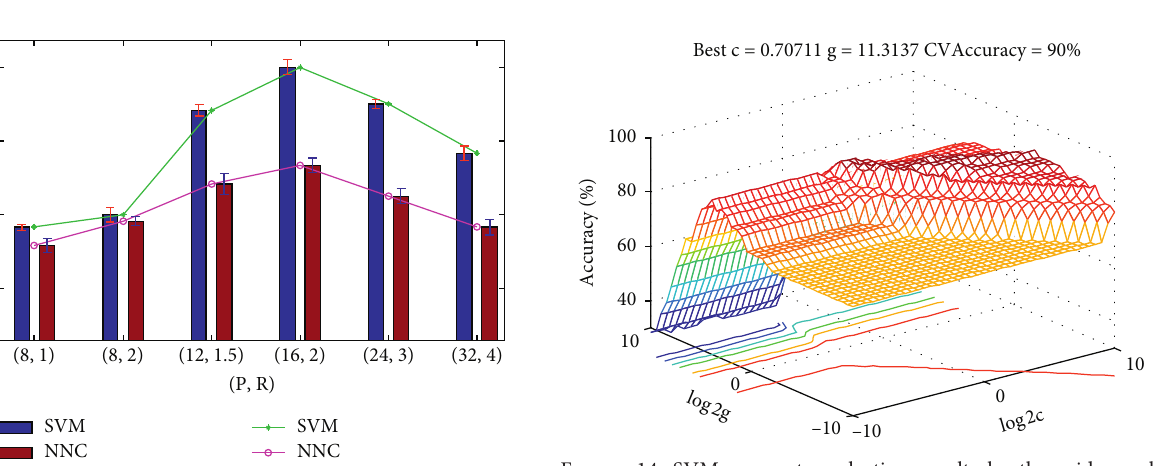
Figure 13: Fault diagnosis result based on circular LBP and WVD time-frequency image.